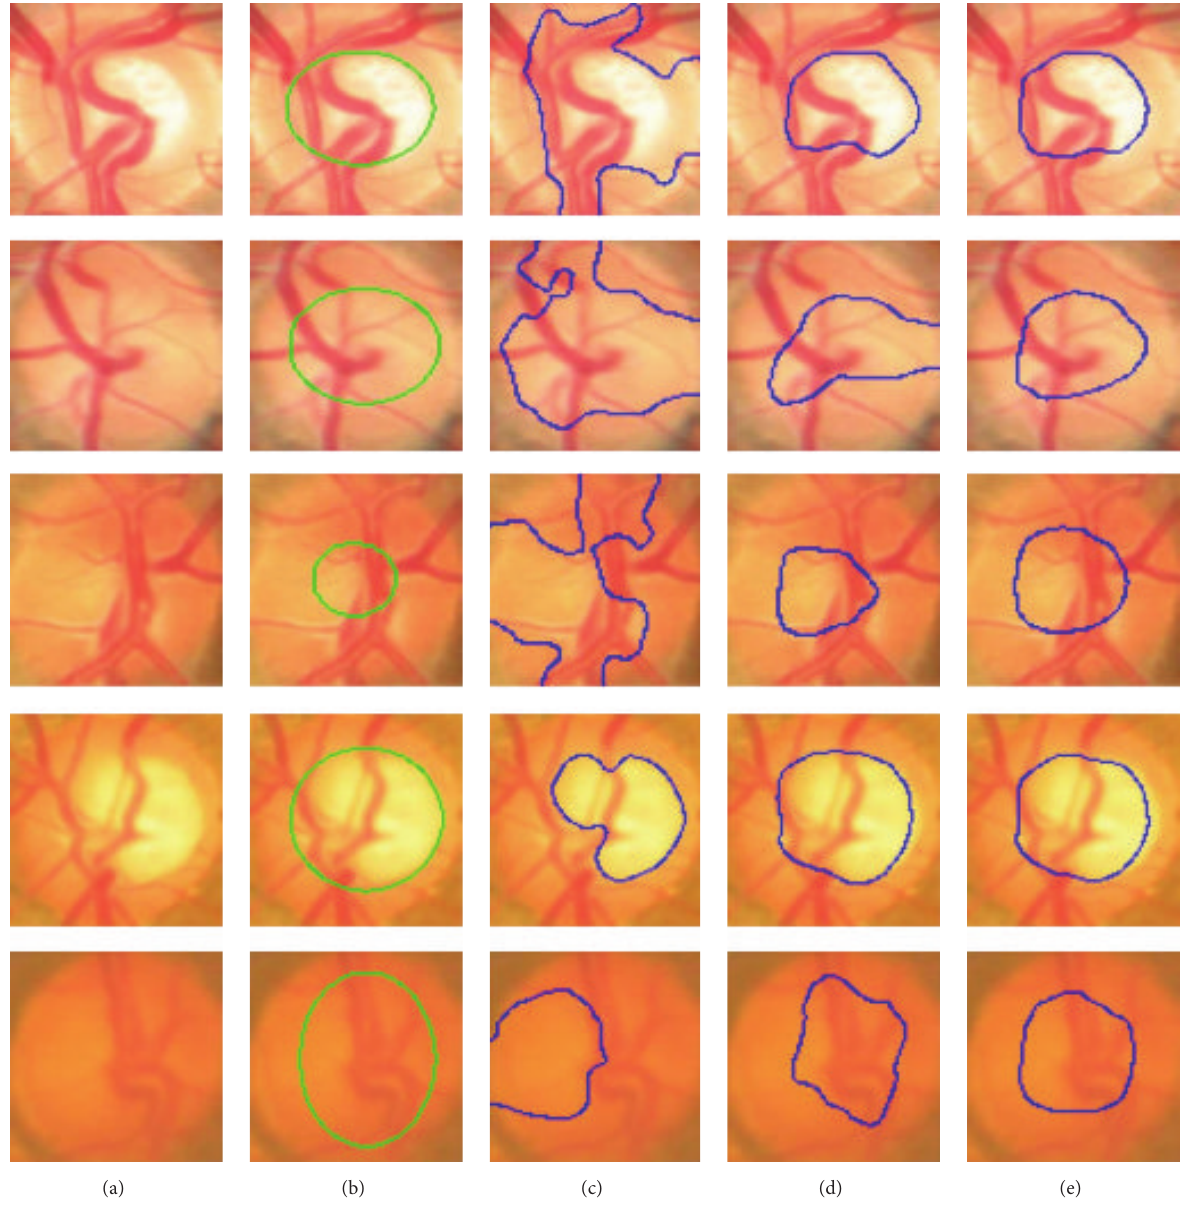
Figure 32: Sample results of the optic cup. From left to right columns: (a) the original images, (b) the manual “ground truth,” and ((c)–(e)) outlines by the proposed method before ellipse fitting.